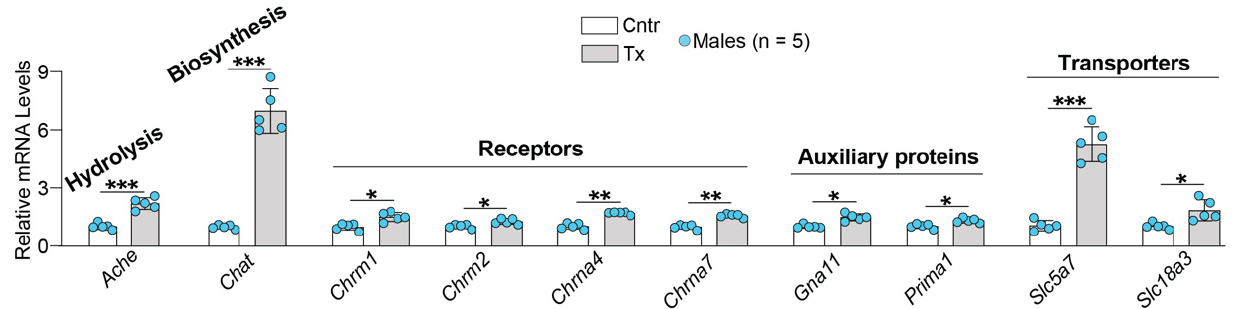
Figure 6. 8,14-DihydroxyEFV effect on brain expression of Ach-related genes. Data represent the mean ± SD of the measurements in five individual male mice. * p ≤ 0.05; ** p ≤ 0.01; *** p ≤ 0.001 as assessed by a two-tailed unpaired Student’s t -test. Cntr, control mice; Tx, treated mice.